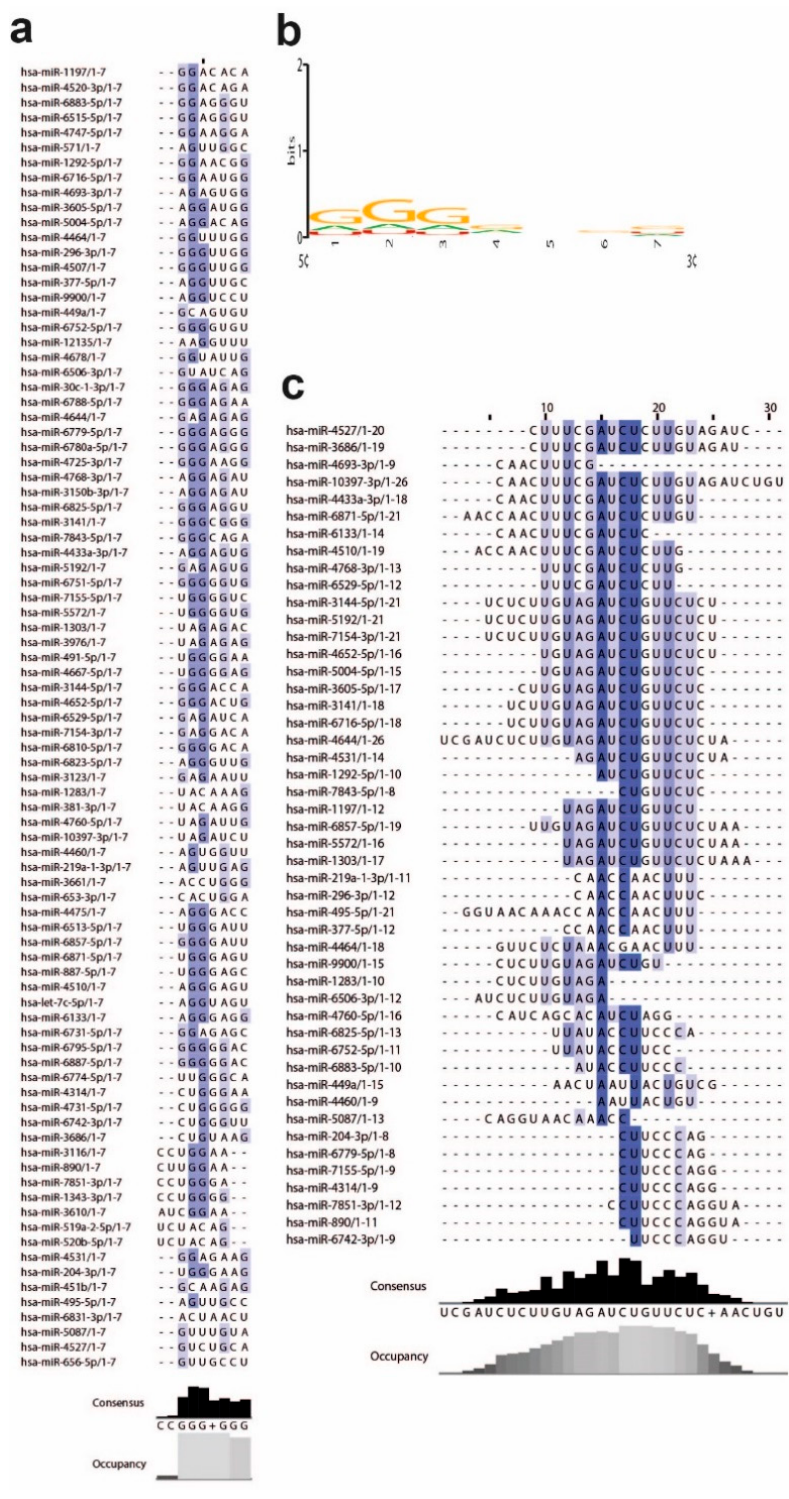
Figure 3. GGG and leader sequence motifs identified using RNA:RNA algorithms against all miRNA candidates. ( a , b ) miRNAs targeting the leader sequence of SARS-CoV-2 5 (cid:48) UTR genome contained the GGG motif in their seed. ( a ) The GGG motif is colored in blue, ( b ) and the MEME representation is indicated in yellow. The consensus and occupancy are reported at the bottom of the list. ( c ) List of miRNAs matching the three motifs identified in the SARS-CoV-2 genome. The blue indicates the position of the motifs and the recurrency. The consensus and occupancy are reported at the bottom of the